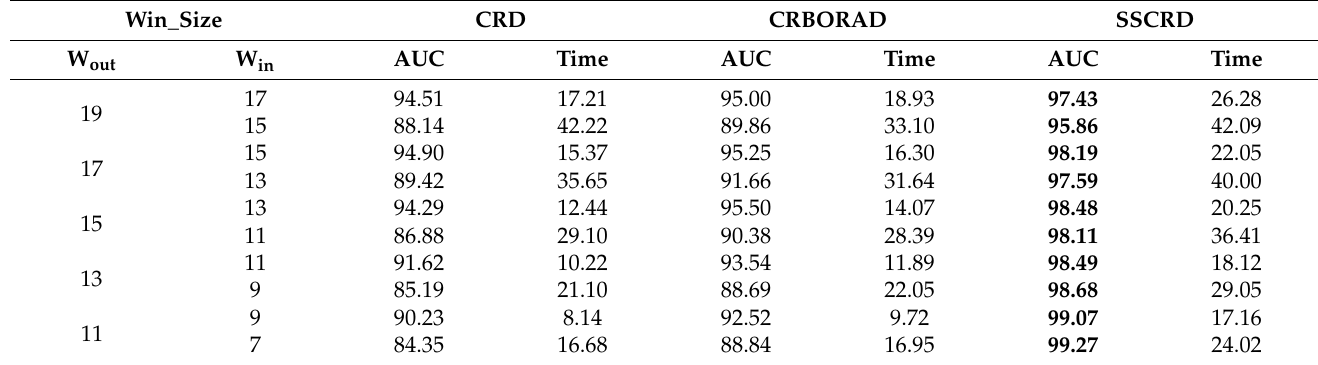
Table 2. AUC values (in %) and computing times (in seconds) for San Diego-II image.